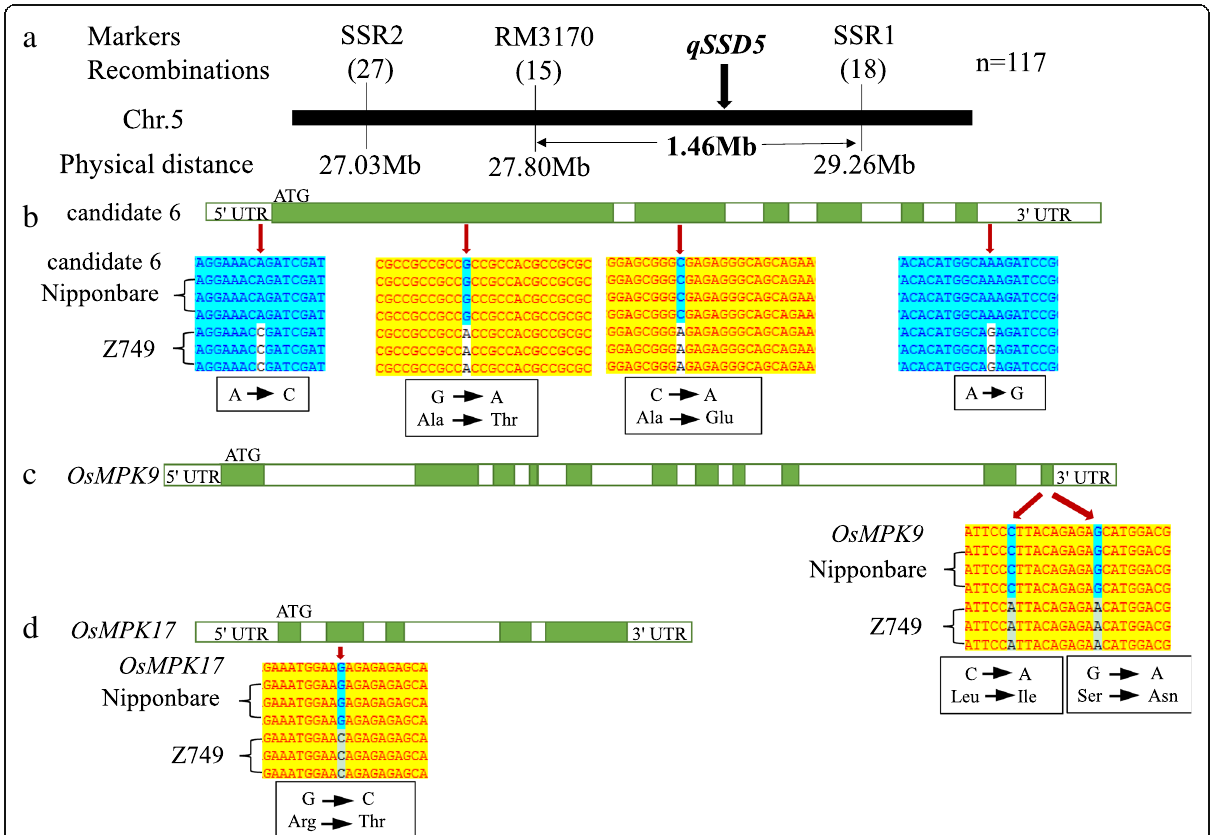
Fig. 5 Fine mapping of qSSD5 and analysis of candidate genes 5, 6 and 7. a Fine mapping of qSSD5 . b – d DNA sequences of candidate gene 6, candidate gene 5 ( OsMPK9 ), and candidate gene 7 ( OsMPK17 ) in Z749 compared with those of Nipponbare. Green indicates the coding sequence (CDS) of exons and white indicates the introns and untranslated regions (UTR) of the genes. The red arrow indicates the site of a